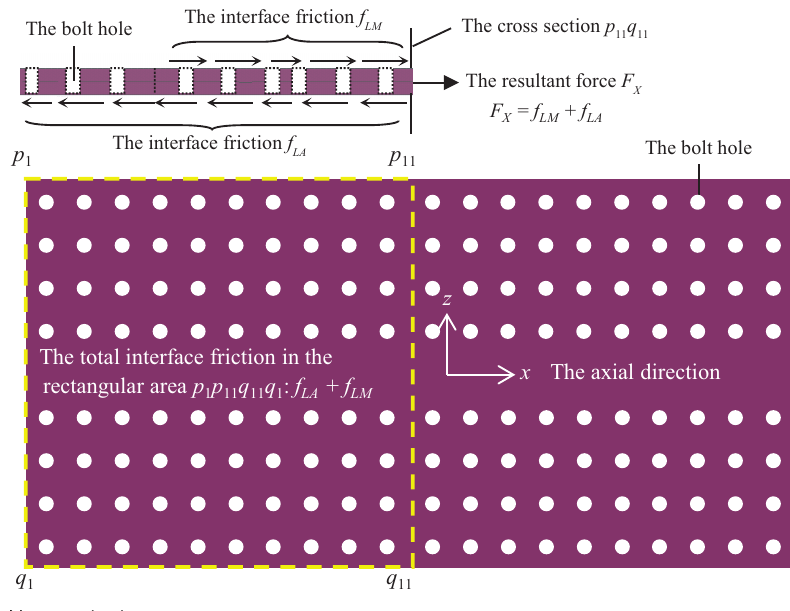
Figure 8. The distribution of interface friction on two contact interfaces of splice plate L